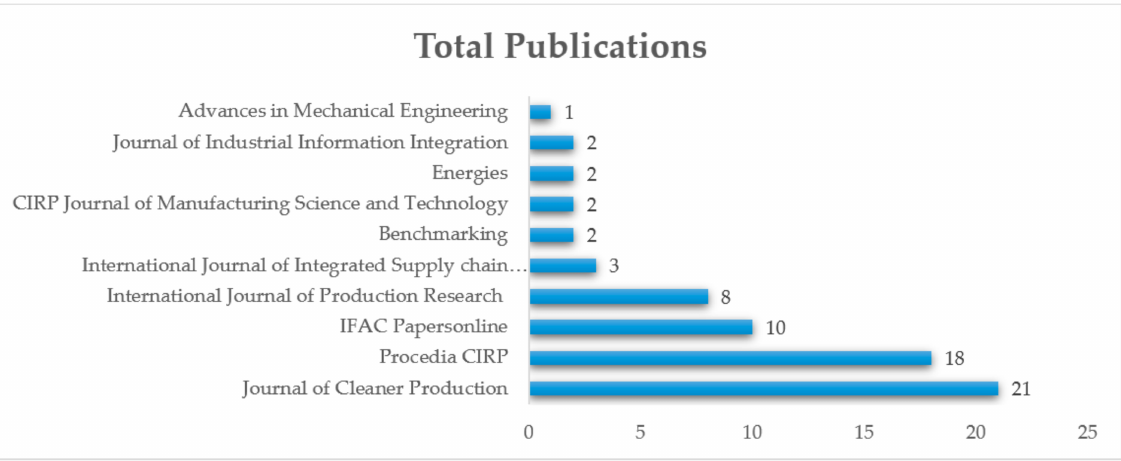
Figure 3. Journal-wise distribution of articles.